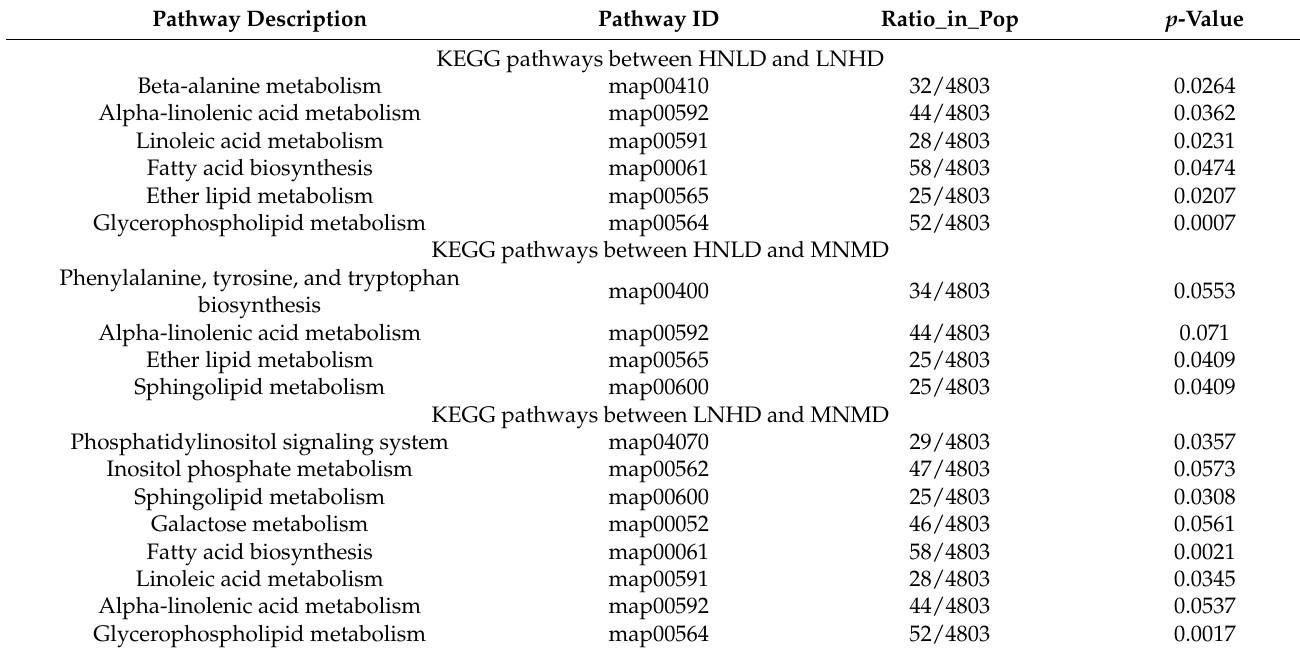
Table 2. KEGG pathways associated with